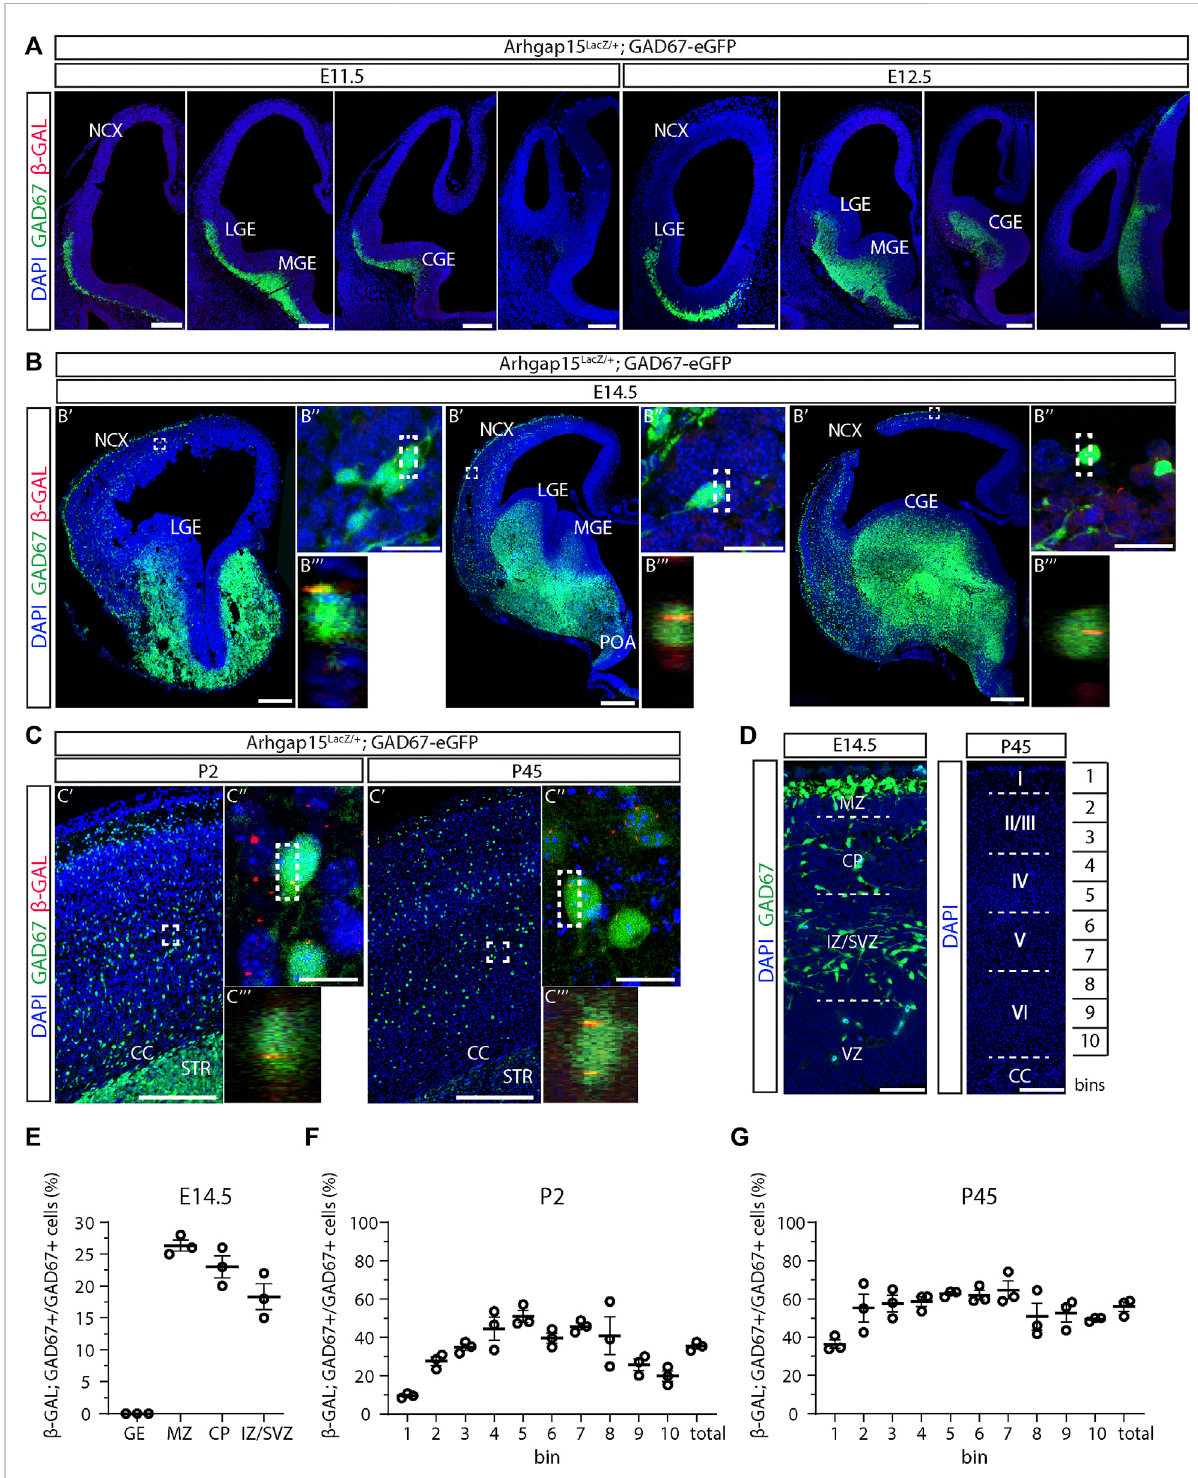
FIGURE 1 Expression ofARHGAP15inembryonicand adultCINs. (A) Maximum intensityprojections ofz-stack images (5 serial imageplanes; zstep size = 2 µm) of coronal sections of E11.5 and E12.5 Arhgap15 LacZ/+ ; GAD67-eGFP brains immunostained for β -GAL. The left-right order of the images recapitulates the rostral-caudal axis. Scale bars: 200 µm. (B) Coronal sections of E14.5 Arhgap15 LacZ/+ ; GAD67-eGFP brains. (B ′ ) Confocal optical sectionsofE14.5 Arhgap15 LacZ/+ ; GAD67-eGFP brainsimmunostainedfor β -GAL;(B ″ )Maximumintensityprojectionsofz-stackimages(20serial